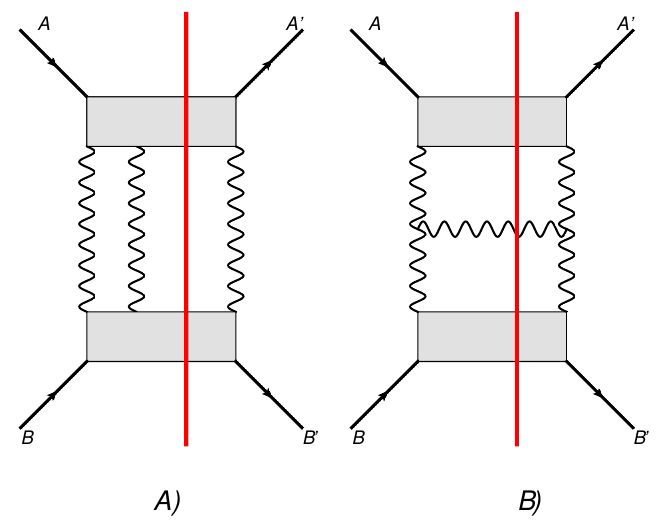
t the asymp- − A ′ B ′ A ′ B ′ Im[ ]. AB | s ≫ 1 ∼ AB A A